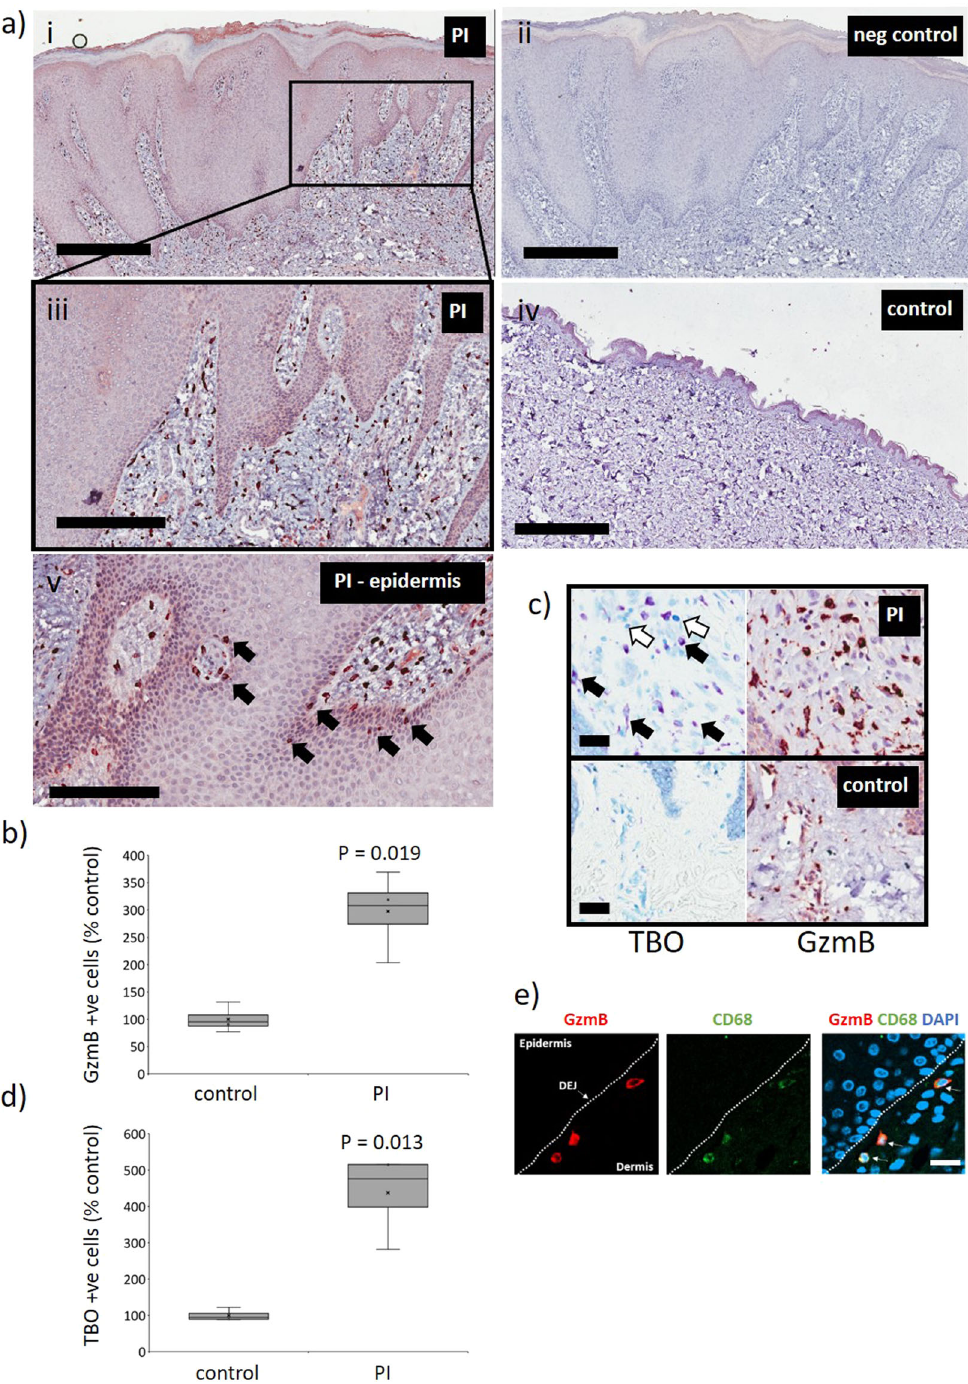
Fig. 1 Elevated GzmB in human PI. a GzmB immunohistochemistry in human PI and unwounded control skin. Scale bars = 600 µm (i, ii, iv), 300 µm (iii), and 200 µm (v). b Quanti fi cation of GzmB + cells. Data presented in box and whisker plot as the percentage increase of GzmB + cells per area compared to the unwounded control, n = 3 samples per group. c TBO (mast cell marker) stain and GzmB immunohistochemistry on sequential tissue sections. Black arrows indicate representative TBO + cells while black arrows indicate representative GzmB + /TBO − cells. Scale bars = 30 µm. d Quanti fi cation of TBO + cells. Data presented as the percentage increase of TBO + cells per area compared to the unwounded control, n = 3 samples per group. e GzmB (red) and CD68 (green, macrophage marker) and DAPI (blue) immune- fl uorescence (IF) of human PI. Dotted line is dermal – epidermal junction (DEJ). Scale bars = 20 (Supplementary Fig. 3). In response to PI induction, there were PI severity was compared between ApoE − / − and HFD GzmB/ no apparent differences in the overall health of the mice, and with ApoE double knockout (DKO) mice (now referred to as DKO mice). no mice requiring euthanasia. Mice from both groups lost Thirty weeks post HFD, and prior to I/R injury, no difference in approximately 7% body weight after 7 days post-initiation of I/R, weight was identi fi ed between the two mouse groups